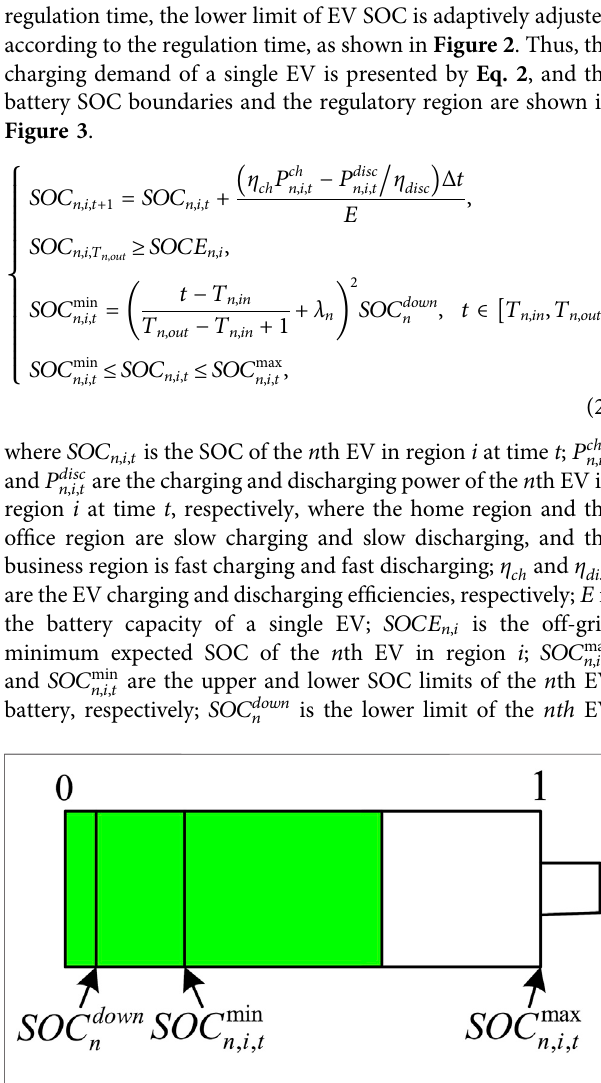
FIGURE2| Schematicdiagramofupper andlowerlimitsofbatterySOC of